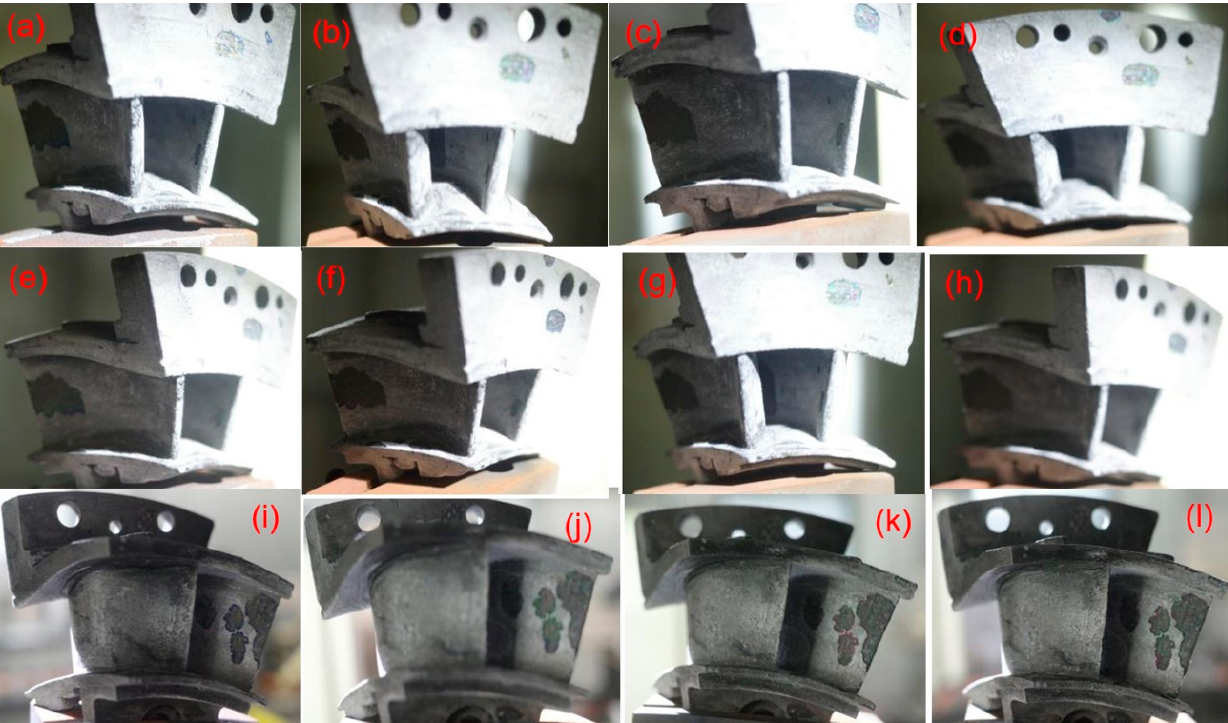
Figure 9. Thermal shock damage of SiC/SiC twin guide vane at target temperature of T = 1400 °C for leading edge at ( a ) N = 100, ( b ) N = 200, ( c ) N = 300, and ( d ) N = 400, the basin region at ( e ) N = 100, ( f ) N = 200, ( g ) N = 300, and ( h ) N = 400, and the back region at ( i ) N = 100, ( j ) N =200, ( k ) N = 300, and ( l ) N = 400.